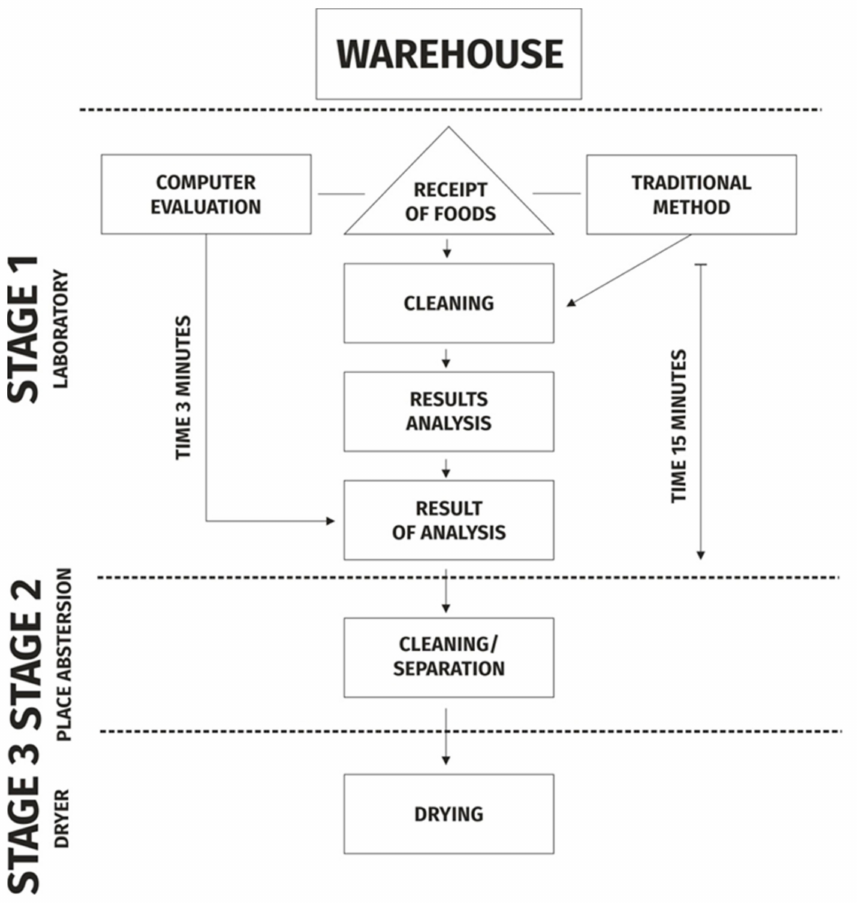
Figure 3. Block diagram of granular material evaluation technology [Source: own